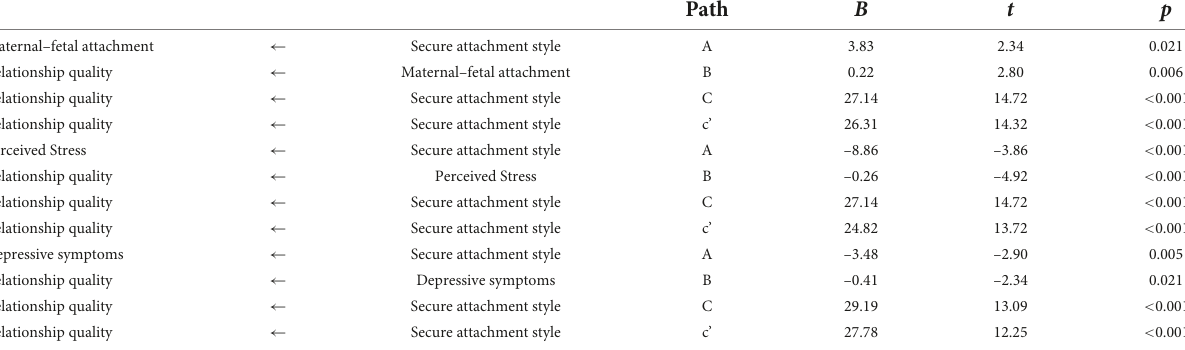
TABLE 10 Non-standardized regression coefficients, Student’s t -test values, and p -value for individual pathways in mediation models. Path B t